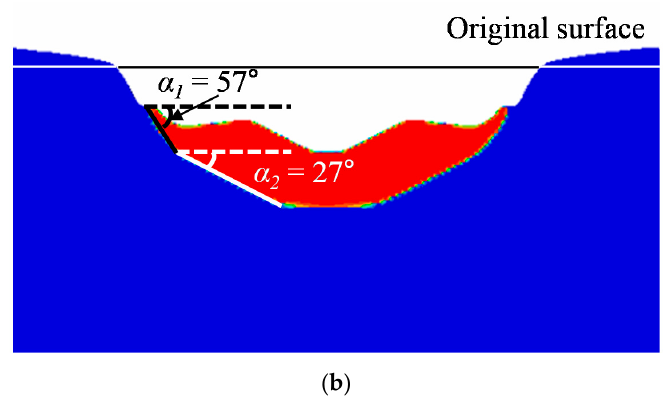
Figure 10. Results of simulating forced replacement method ( H = 2.0 m): ( a ) Replacement depth, range and height of heave soil; ( b ) replacement angle.